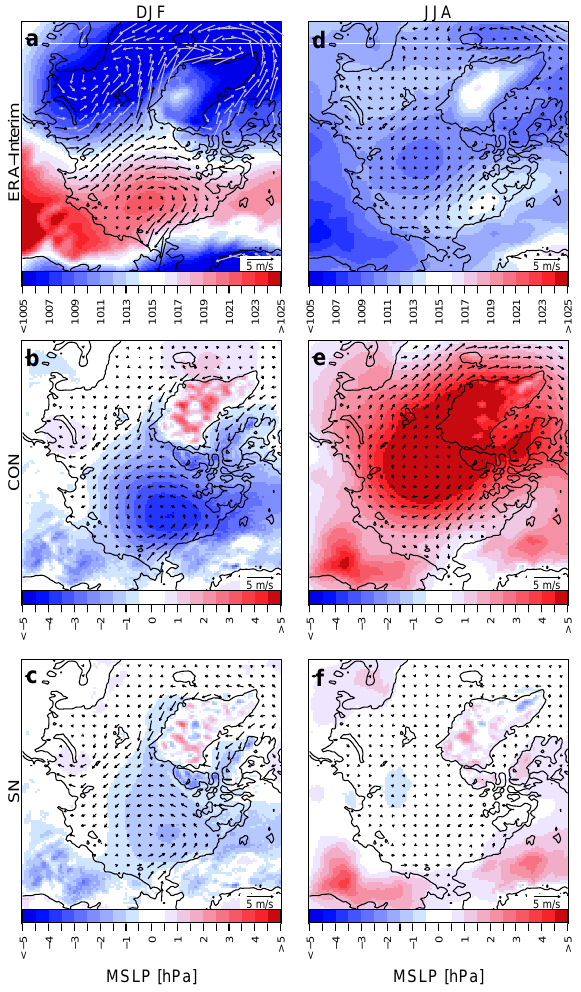
Fig. 3. MSLP of the ERA-Interim (top), and bias of CON (middle) and SN (bottom), with respect to ERA-Interim, for DJF (left) and JJA (right). Arrows indicate anomalies of wind speed and direction. Only winds over the ocean are shown for reasons of clarity.